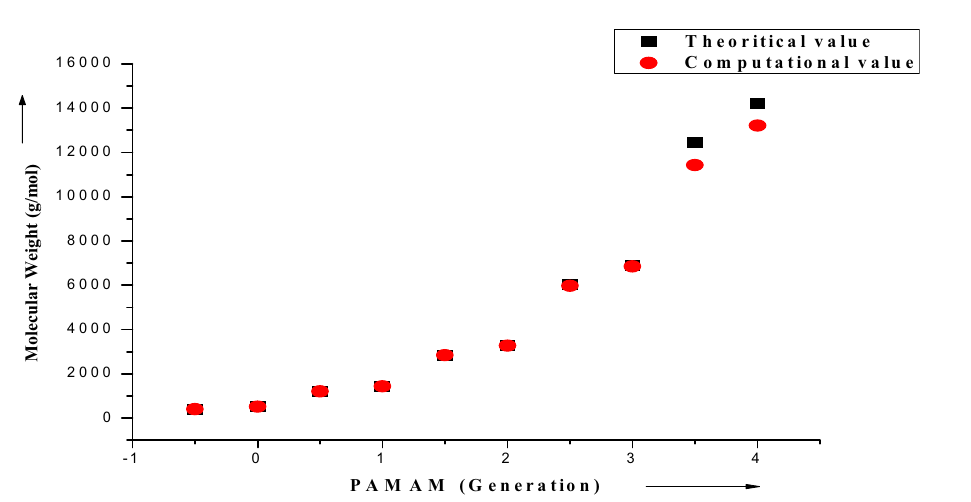
Table 1. Molecular dynamics of different generation of polyamidoamine dendrimer.